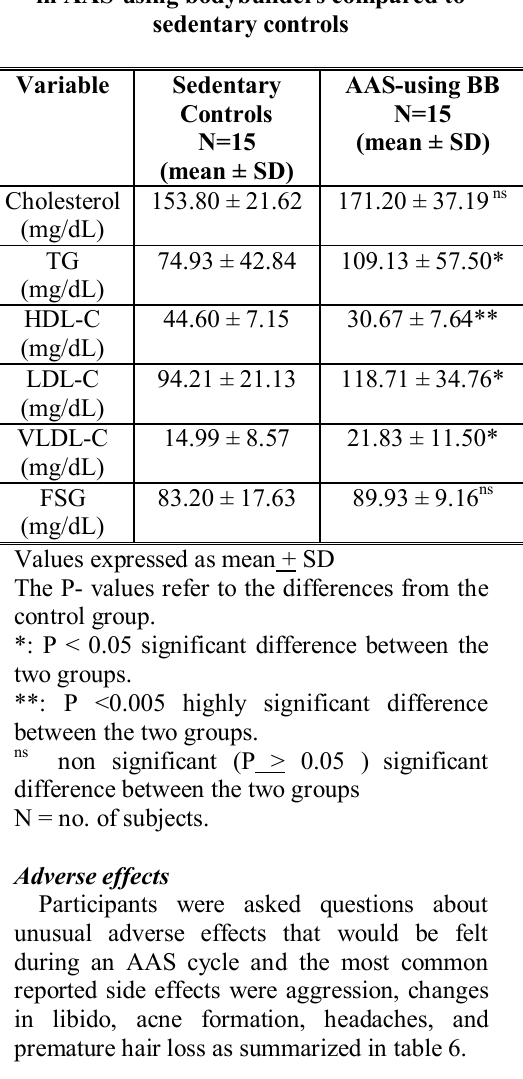
Table 5: Effects of anabolic androgenic steroids on lipid profile and serum glucose in AAS-using bodybuilders compared to